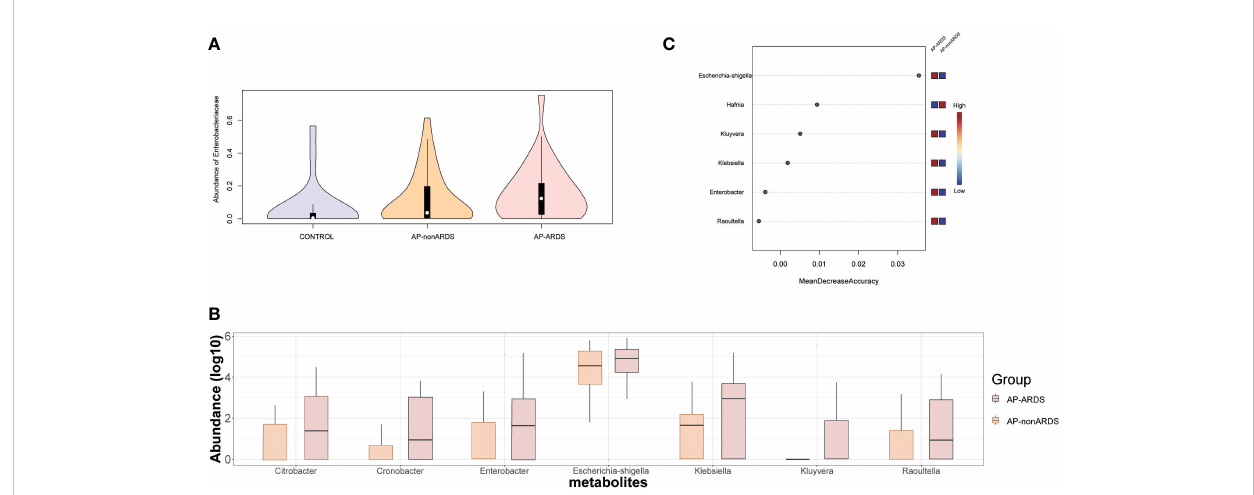
FIGURE 5 Enterobacteriaceae Analysis and Model Predicting. (A) The relative abundance of Enterobacteriaceae in Control, AP-nonARDS, and AP-ARDS group. (B) Major genus in Enterobacteriaceae family between AP-nonARDS, and AP-ARDS group. (C) Random forest model predicting. It screened out the Escherichia-shigella genus as the most signi fi cant feature for predicting